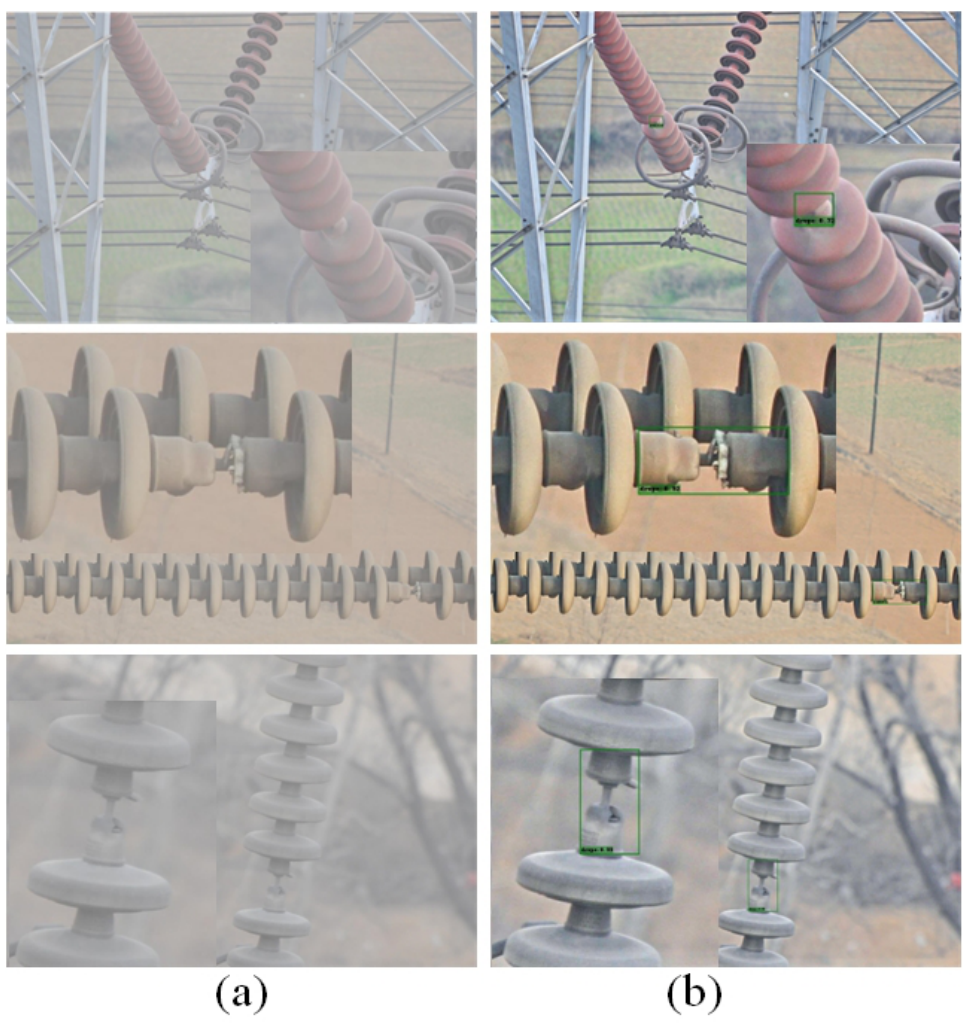
Figure 13. Visualization results of the FA-SSD and FA-SSD with defogging algorithm. ( a ) FA-SSD. ( b ) FA-SSD with defogging